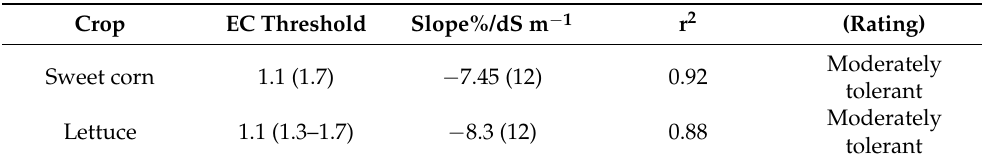
Table 2. Salt tolerance of corn and lettuce expressed as electrical conductivity at the threshold when the slope intercepted Y r = 100